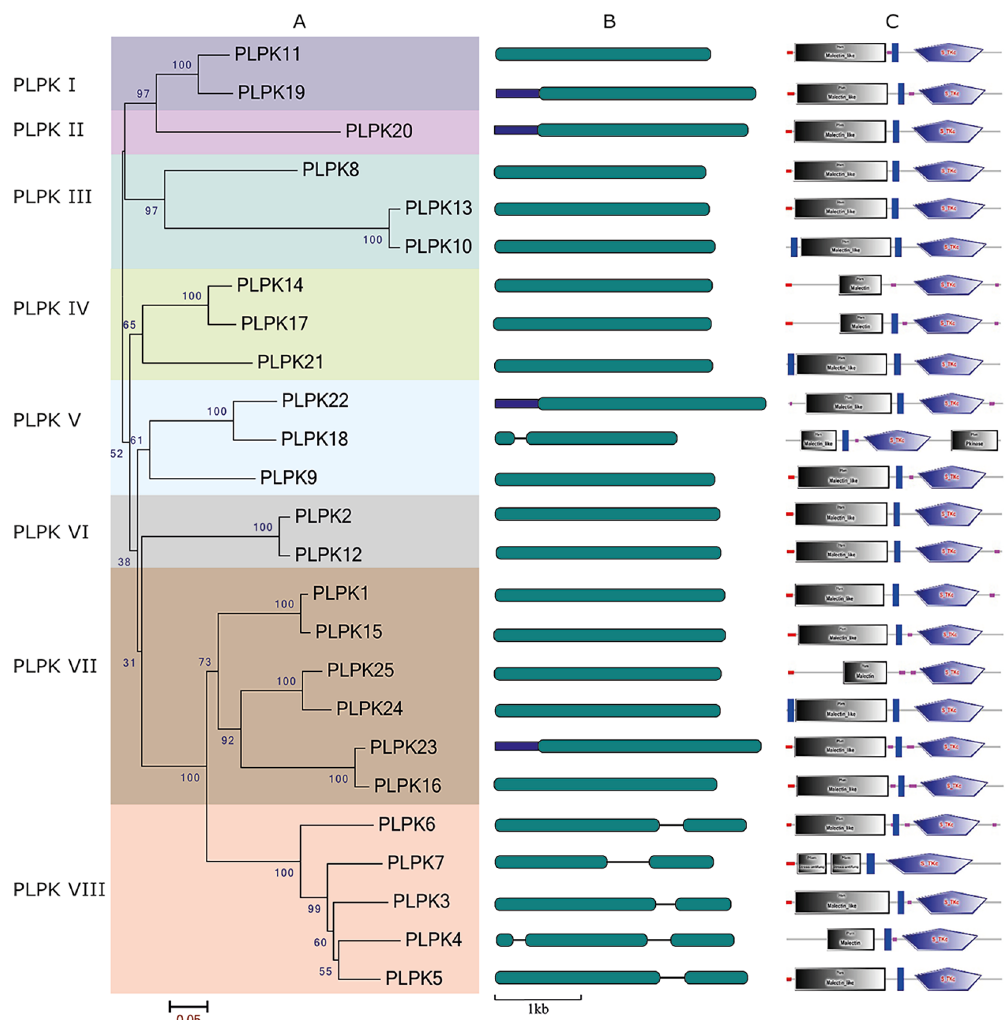
Fig 3. Phylogenetic analysis of pepper PLPKs. A: A rooted phylogenetic tree was constructed using the predicted pepper PLPK sequences. The phylogenetic tree was constructed using the NJ method (1000 bootstrap replicates) as implemented in the MEGA 6.0 software. The name of each subclass is indicated. Phylogenetic analysis showed distinct clustering of PLPKs into eight subclasses (PLPK I – PLKPK VIII). B: Exon-intron structures of pepper PLPK genes. UTRs and exons are shown as blue and dark cyan boxes, respectively, and introns are shown as black lines. C: Structural and functional domains identified by the SMART program. Most pepper PLPKs contained a signal peptide region (red box), a malectin-like region, a transmembrane (TM) region (blue box), and a STK domain. PLPK18, which belongs to the PLPK V class, has an additional kinase domain at the C-terminus. PLPK7, which belongs to the PLPK VIII subclass, includes two stress-antifung domains at the N-terminus. In addition, low complexity regions (violet box) were present in several